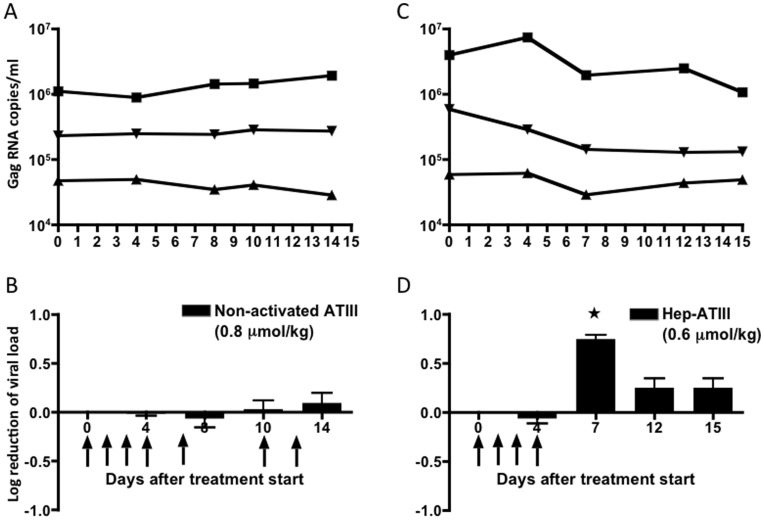

In vivo anti-viral activity of non-activated and heparin-activated ATIII in rhesus macaques.(A) Viral loads as RNA copies/ml of chronically SIVmac239 infected rhesus macaques treated with 0.8 µmol/kg non-activated ATIII (n = 3) and (B) corresponding log10 reduction of viral load of same treatment group. (C) Viral loads as RNA copies/ml of chronically SIVmac239 infected rhesus macaques treated with 0.6 µmol/kg heparin-activated ATIII (n = 3) and (D) corresponding log10 reduction of viral load of same treatment group. Administration via i. v. inoculation is shown at indicated time points depicted by arrows. Viral load was measured and compared to animals before treatment (day 0). *, P<0.05, paired T-test, compared to pre-treatment (day 0). Data are shown as mean ± S.E.